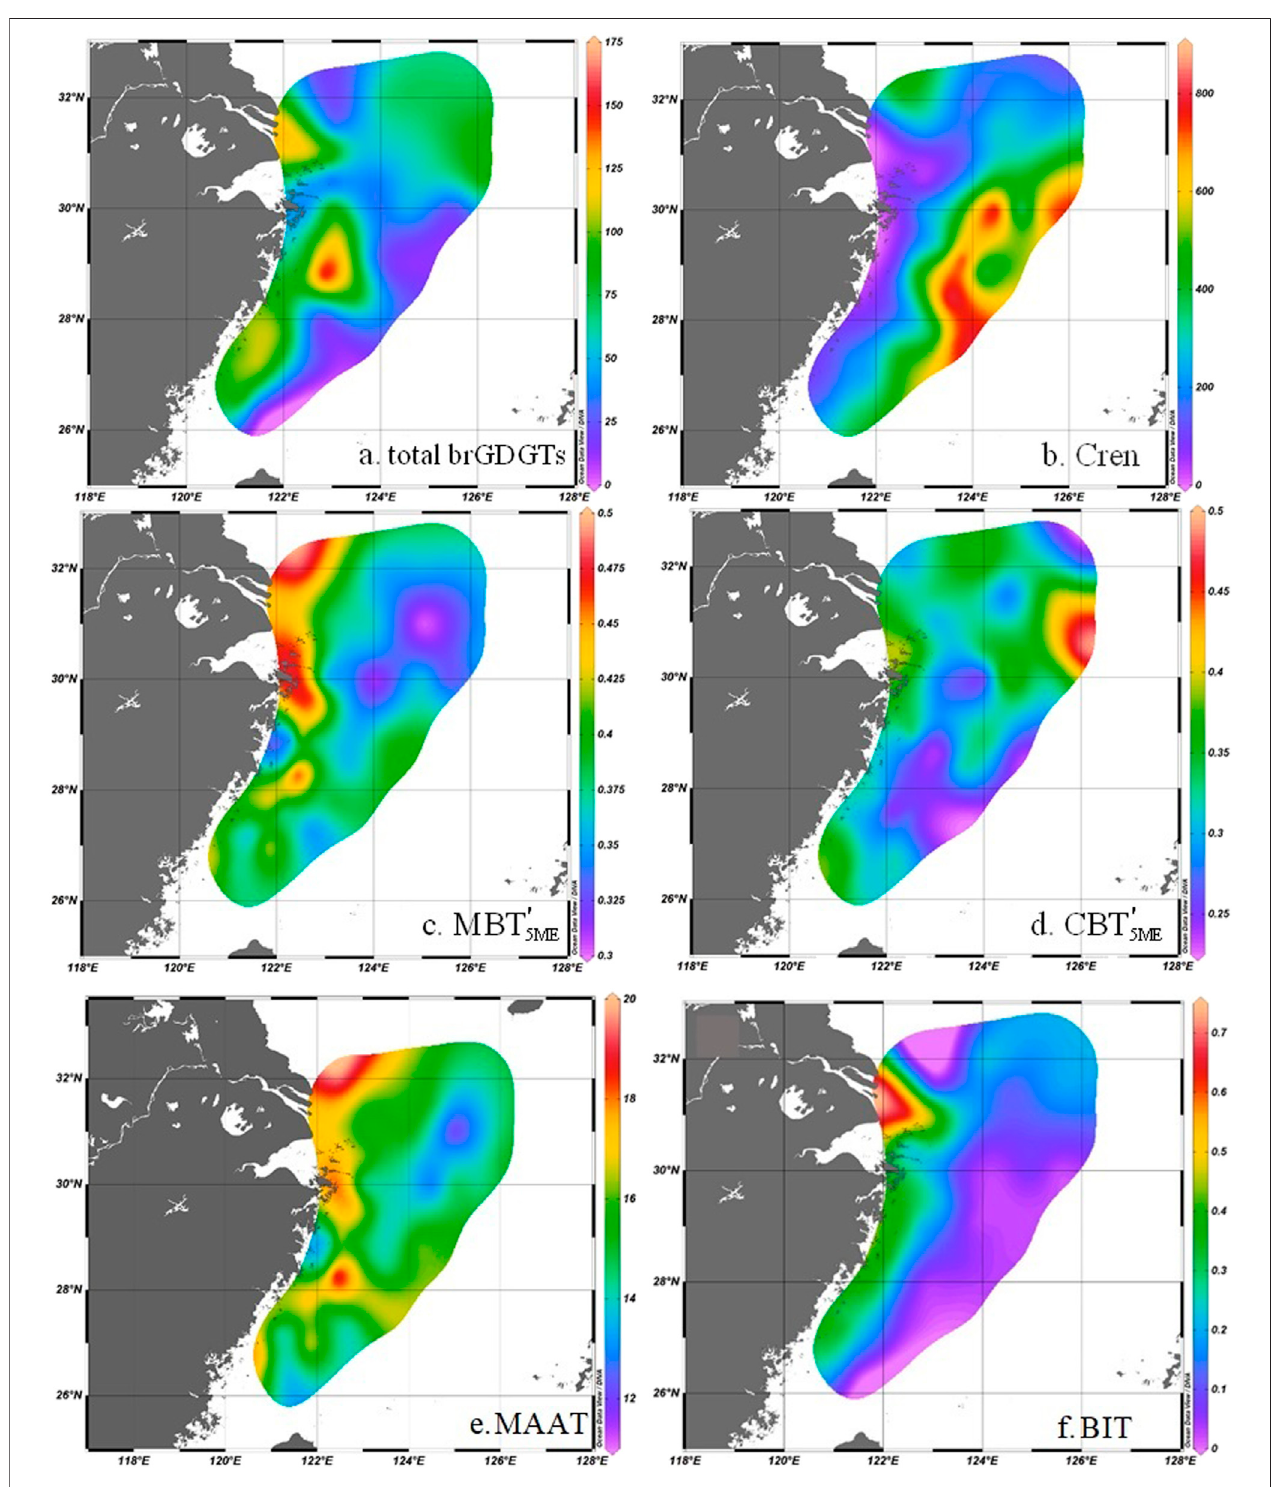
FIGURE 2 | Spatial distributions of brGDGTs and Cren in the ECS and MBT ′ 5ME, CBT ′ 5ME, MAAT, BIT, #Rings tetra , and IIIa/IIa derived from brGDGTs. (A) Total brGDGTs (ng/g); (B) Cren (ng/g); (C) MBT ′ 5ME; (D) CBT ′ 5ME; (E) MAAT; (F) BIT.